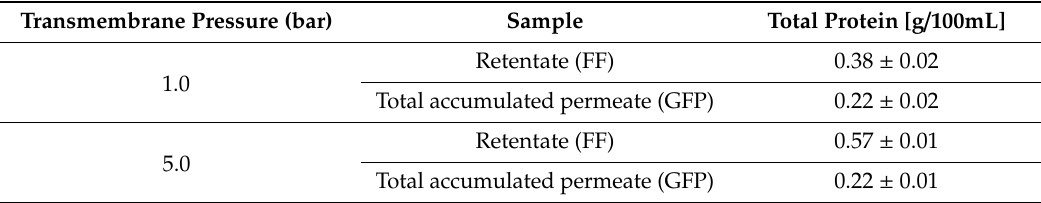
Figure 4. Ultrafiltration experiments at room temperature using di ff erent pressures: permeability plotted as a function of the volume reduction factor, VRF. Table 7. Composition of protein / peptides of the peaks of the retentates and permeates of the pre-treated sardine cooking wastewaters obtained when using the GH membrane at 1.0 bar and 5.0 bar transmembrane pressures by Kjeldahl method. The results are given in g per 100 mL of sample.